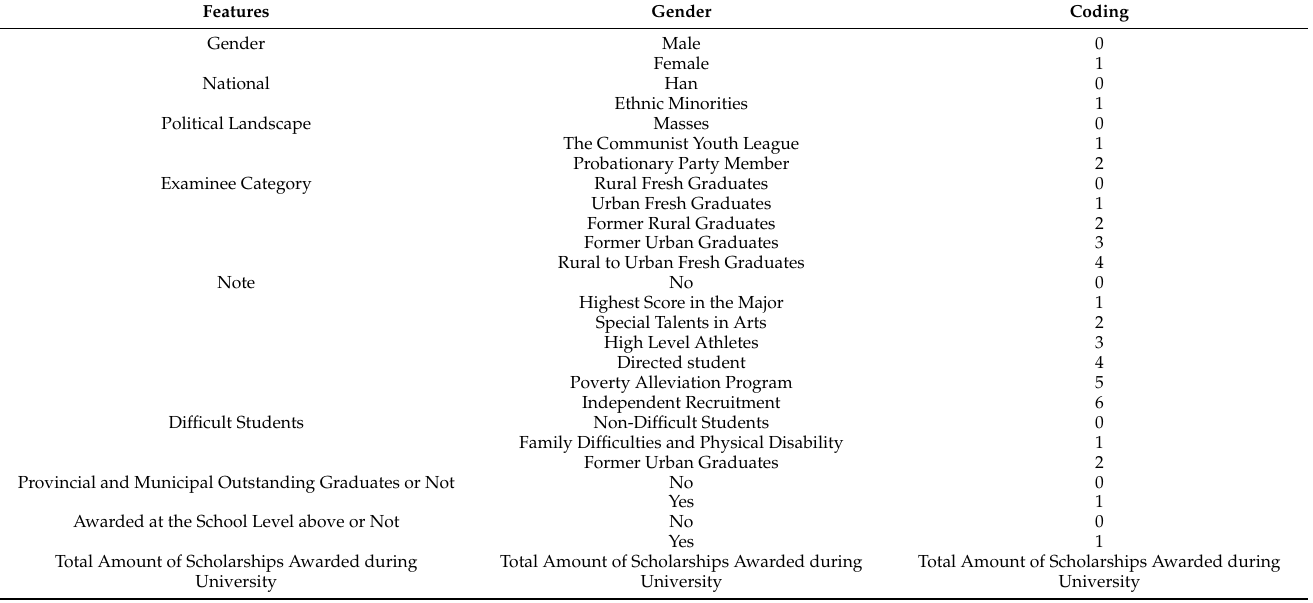
Table 2. Data Processing and